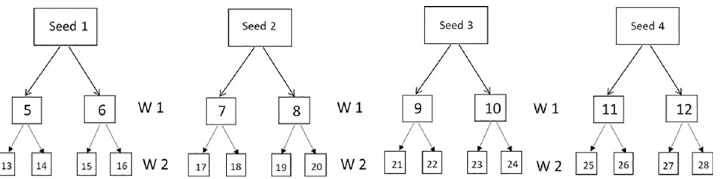
Fig 1. Respondent-driven sampling for out of school youth–a schematic representation of four seeds. W 1: wave 1, W 2: wave